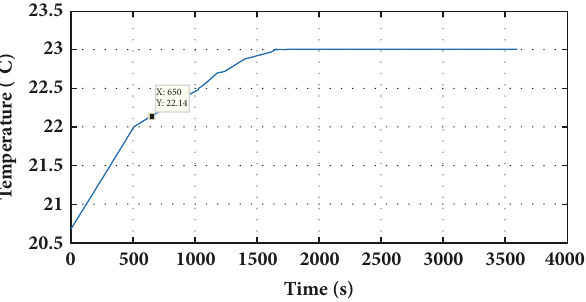
Figure 23: Zone temperature T z response.